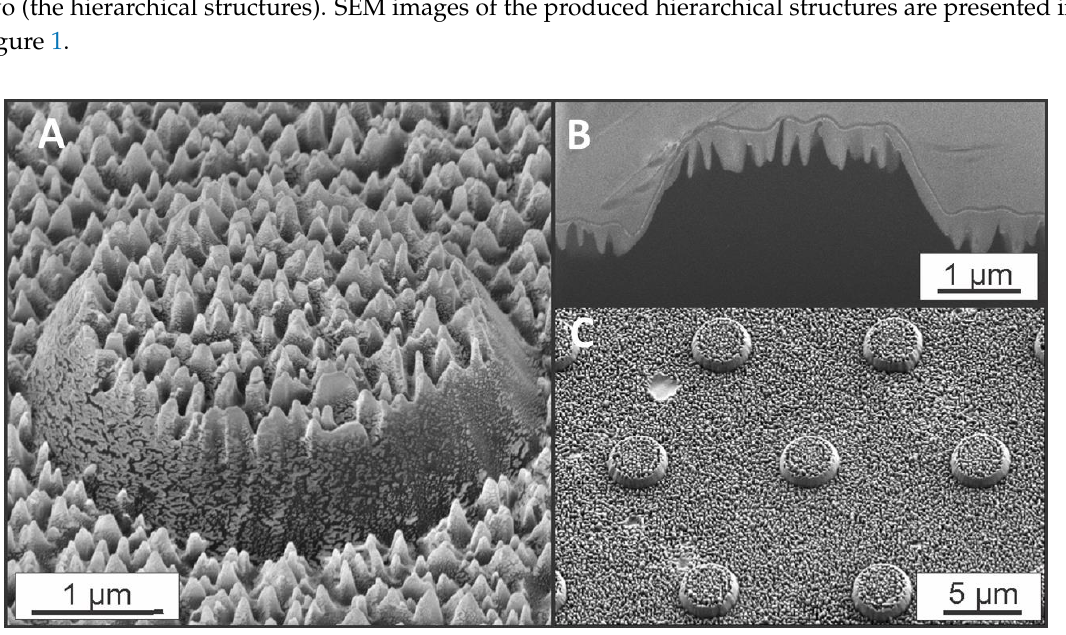
Figure 1. A hierarchical pattern produced in polypropylene (PP) using a roll-to-roll extrusion coating process. ( A ) The pattern coated with 10 nm Au at 45° angle. ( B ) Focused ion beam-SEM (FIB-SEM) cross-section of the pattern, image taken at 52° tilting angle, using tilt compensation function. ( C ) An overview image of the pattern in PP (with 10 nm Au), taken at 30° angle.